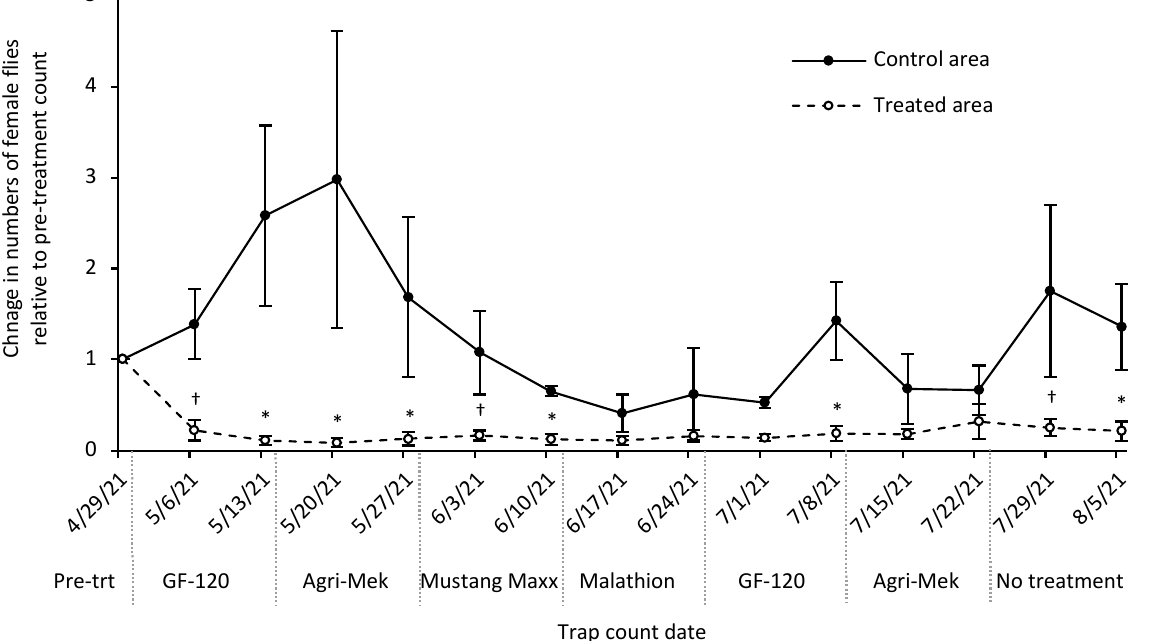
Figure 3. The change in the numbers of female Zeugodacus cucurbitae caught in torula yeast traps relative to the pre-treatment count during the insecticide rotation experiment on the Maui commercial farm. The dates (m/d/y) refer to the date that traps were collected and counted; the insecticide was applied one week prior to the trap count date. Grey solid line represents no change from pre- treatment count. Asterisk above treated area symbols indicate a significant difference between control and treated areas based on means contrasts for each date (* p < 0.05, † p < 0.10). The percentage of marketable fruits harvested by the farmer was approximately 51–53% at the start of the insecticide rotation. This increased to 85% after four insecticide applications in the treated area and almost all fruits were harvestable after three more applications (Table 5). The percentage of harvestable yield in the control area increased gradually over time, likely as the overall numbers of flies on the farm decreased from insecticide applications in the treatment area. Overall, the mean percent of marketable fruit yield per week was significantly higher in the treated area (81%) than in the control area (62%) (treatment: F 1,7 = 13.33, p =